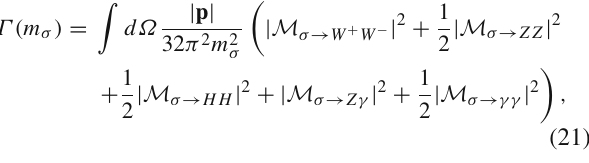
for a scalar resonance with mass m σ = 1 TeV and dif- ferent couplings F σ W = 10 . 0 , 4 . 5 , 2 . 0 TeV − 1 . These val- ues correspond to the anomalous quartic coupling F T